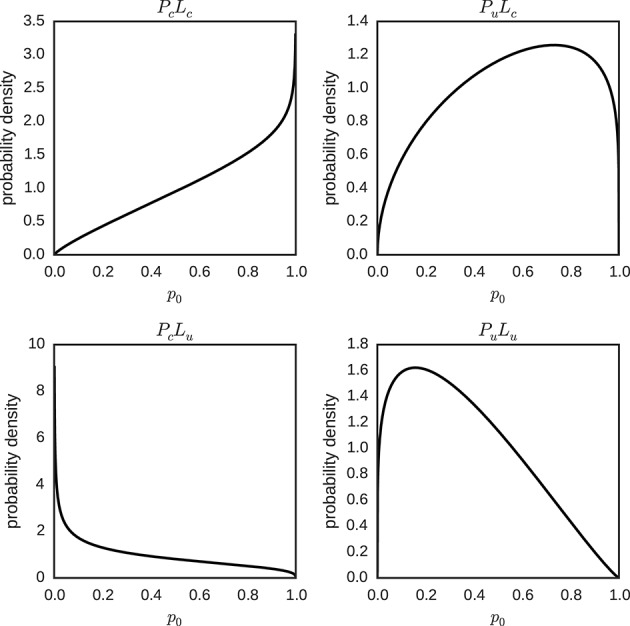
Hierarchical distributions for parameter p0 in different conditions (PcLc, PuLc, PcLu and PuLu). The hierarchical distributions p0 ~ beta(φλ, (1 − φ)λ) use the posterior means of the hyper-parameters φ and λ for the different conditions.